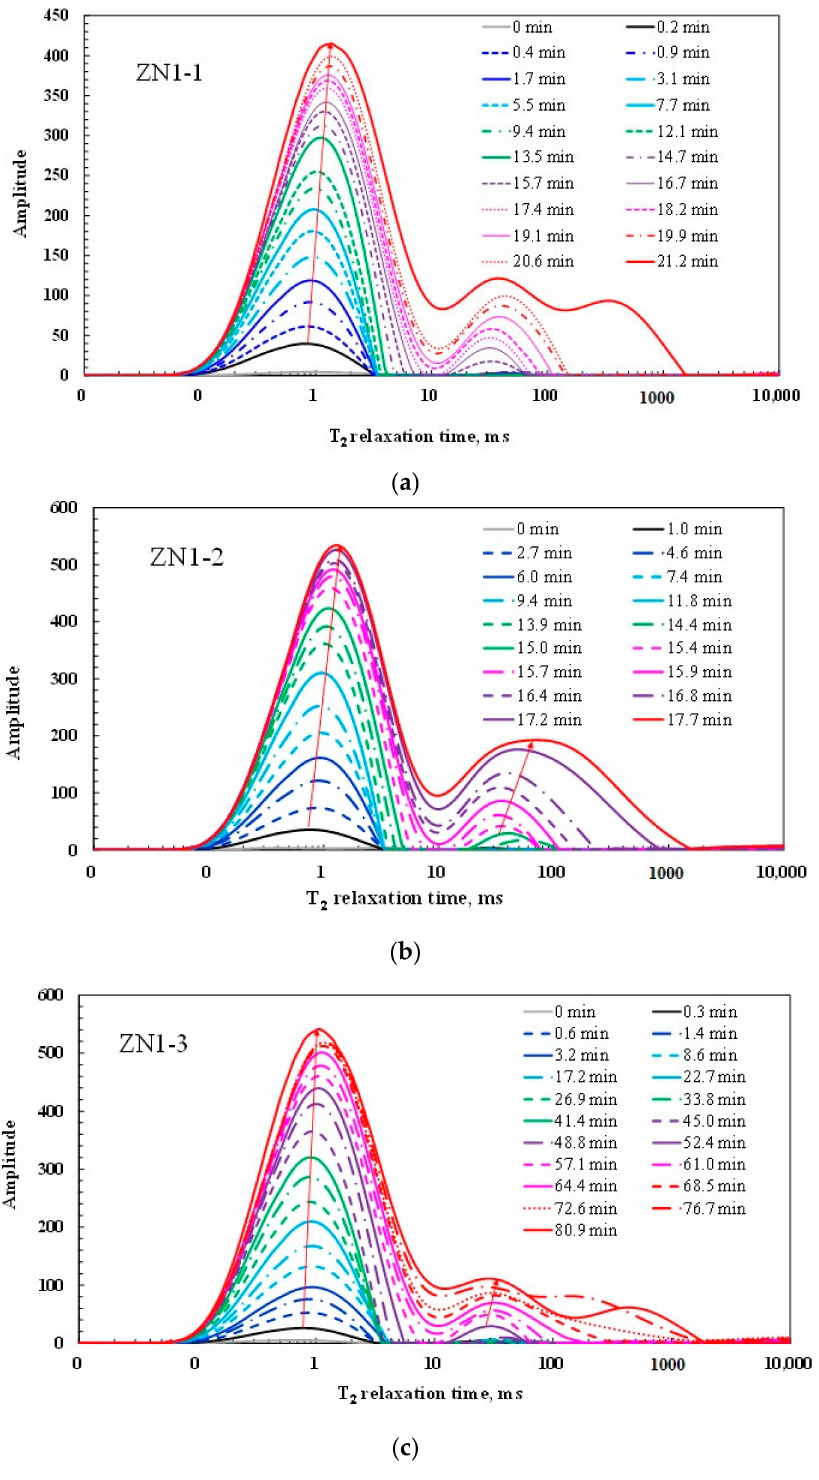
Figure 5. T 2 spectra vs. imbibition of ZN formation. ( a ) ZN1-1; ( b ) ZN1-2; ( c )